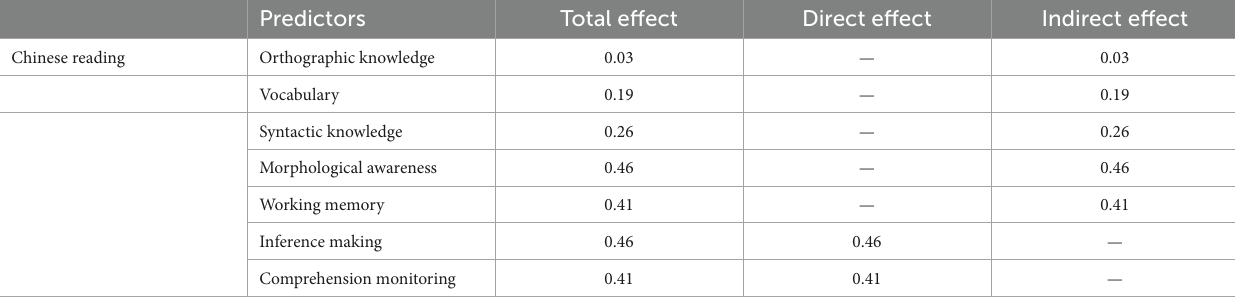
TABLE 4 Direct, indirect, and total effect estimates of the model predictors on L2 Chinese